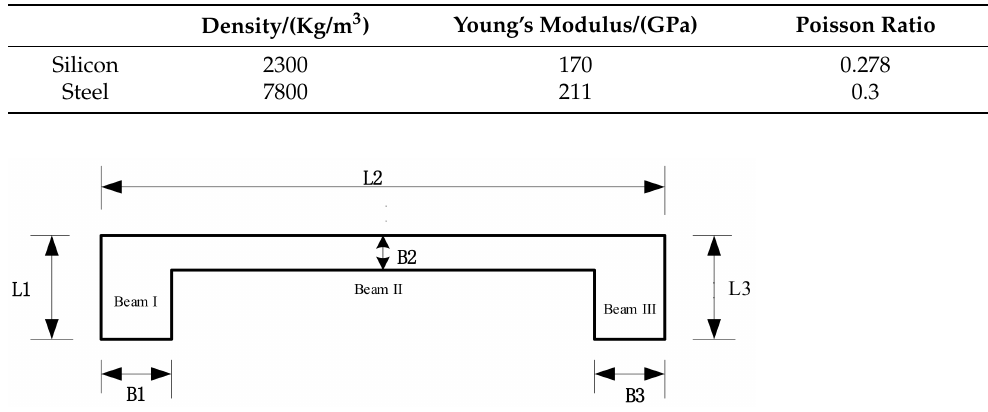
Table 1. Physical parameters of the resonator.